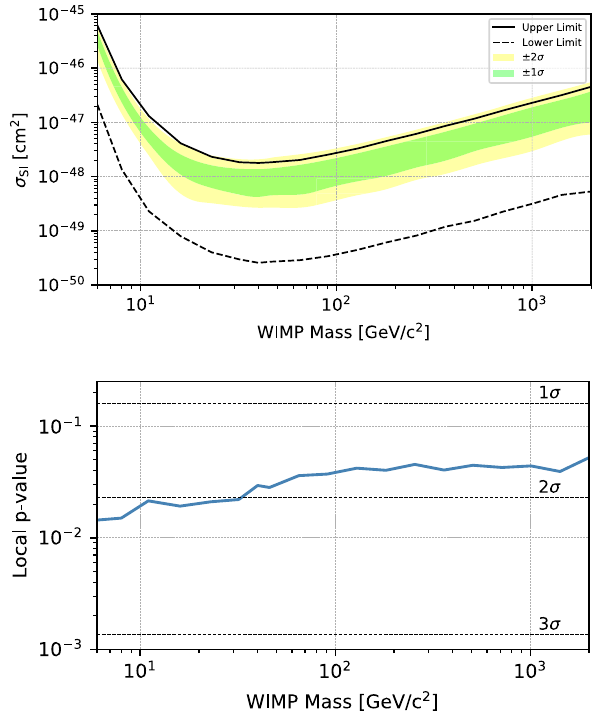
Fig. 3 Top: example two-sided 90% CL limits (black) calculated from a single simulated background-only dataset, where the lower bound has “lifted off” from zero despite there being no signal in the data set. The green and yellow bands indicate bands containing 68% and 95% of upper limits under the null hypothesis. Bottom: the p value for the background-only hypothesis as a function of mass. These data do not represent a statistically significant rejection of the background-only